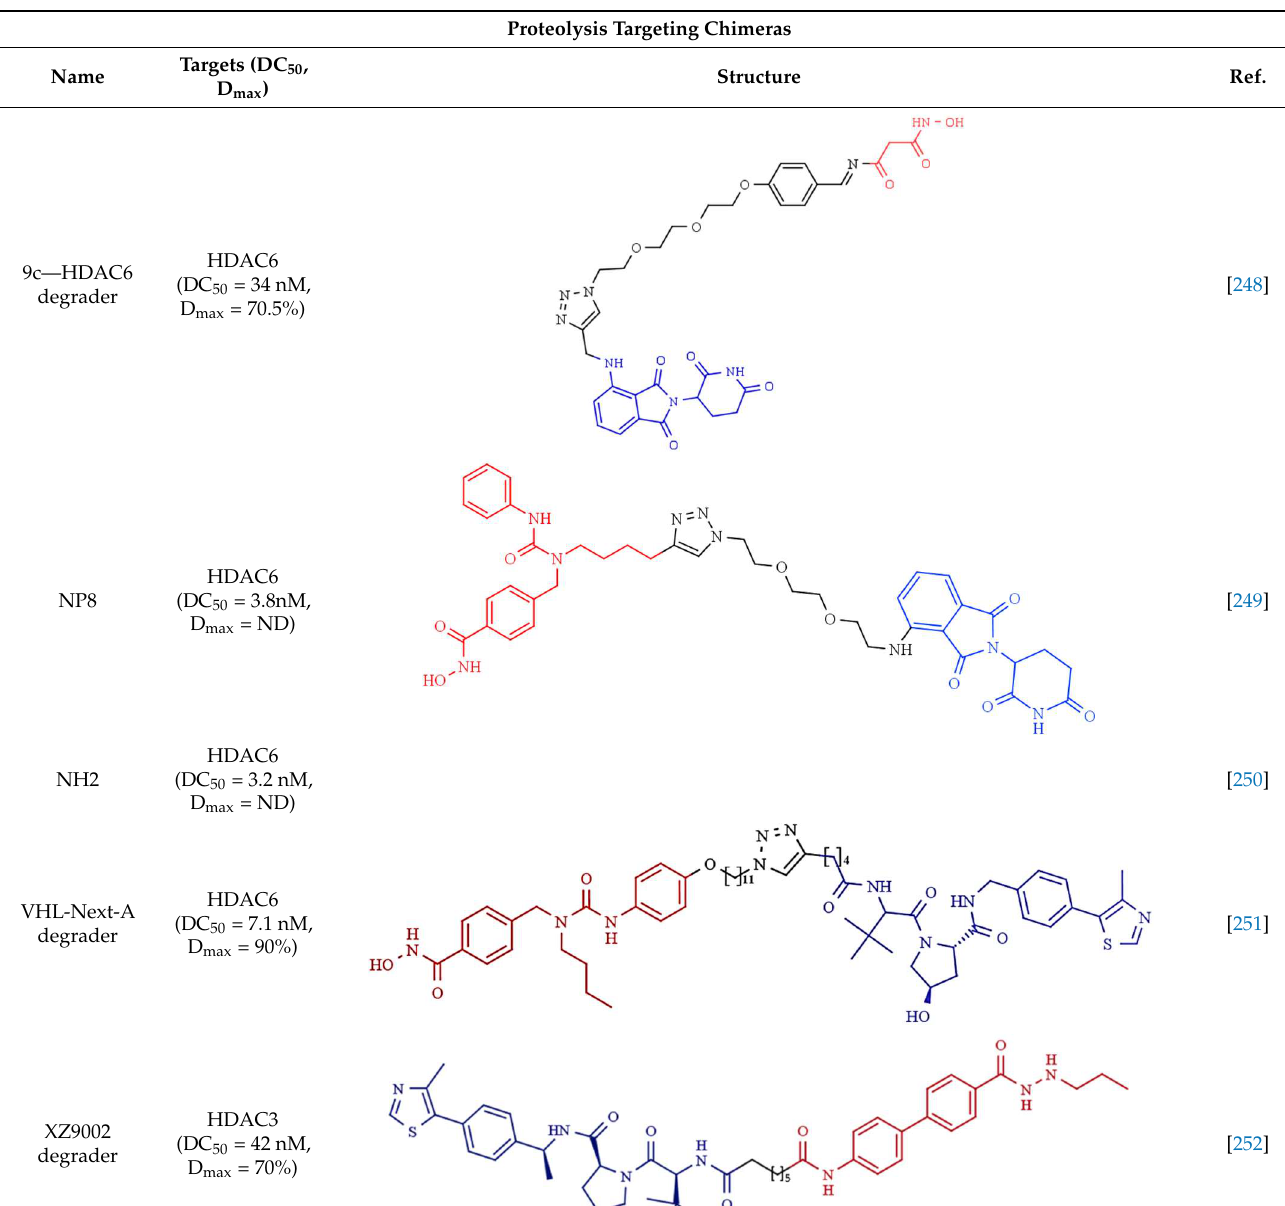
Table 5. Selected proteolysis targeting chimeras for HDACs degradation. Red shows HDAC phar- macophoric features, black shows linker regions, and blue shows E3 ligases. VHL: Von Hippel–Lindau; DC 50 , concentration to reduce the target protein expression in a 50%; DC max : maximum percentage of degradation; ND: non-determined.